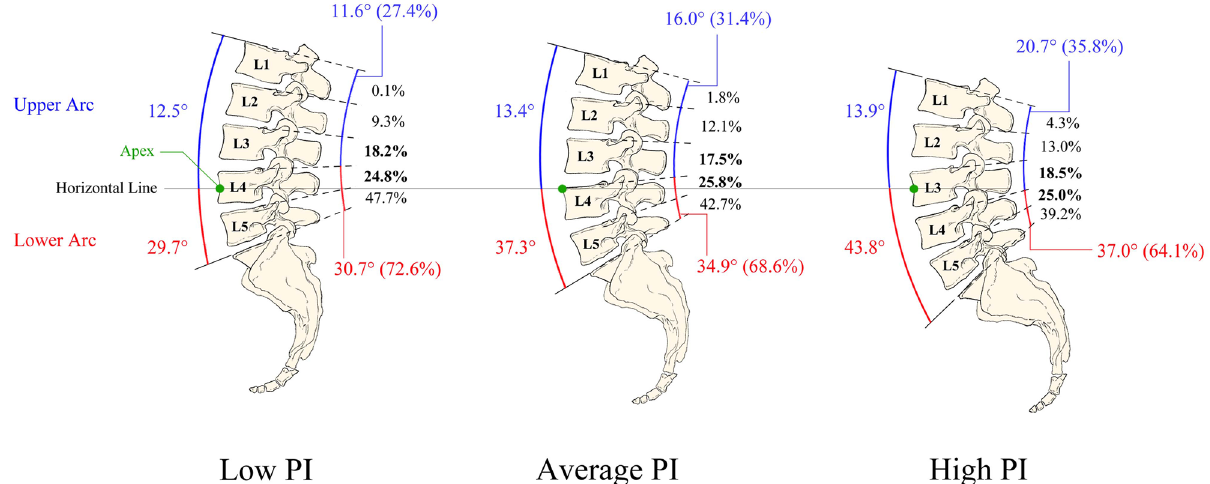
Figure 3. Correlation between pelvic morphology and lumbar spine. The angle between the horizontal line of the apex and the superior endplate of S1 (lower arc) is equal to the sacral slope, and the angle between the superior endplate of L1 and the horizontal line of the apex (upper arc) was obtained through subtracting the sacral slope from the lumbar lordosis lumbar lordosis, the percentage increase between G1 and G2 and between G2 and G3 was 37.9% and 29.4%, respectively, but was only 13.7% (G1 to G2) and 6% (G2 to G3) for distal lumbar lordosis. Although proximal lumbar lordosis accounted for a smaller proportion of total lumbar lordosis than did distal lumbar lordosis, proximal lumbar lordosis had a greater percentage increase than distal lumbar lordosis from the low to the high pelvic incidence groups. These findings indicated that proximal lumbar lordosis and distal lumbar lordosis were simultaneously affected by the pelvic incidence value and that, between the groups, the variation of proximal